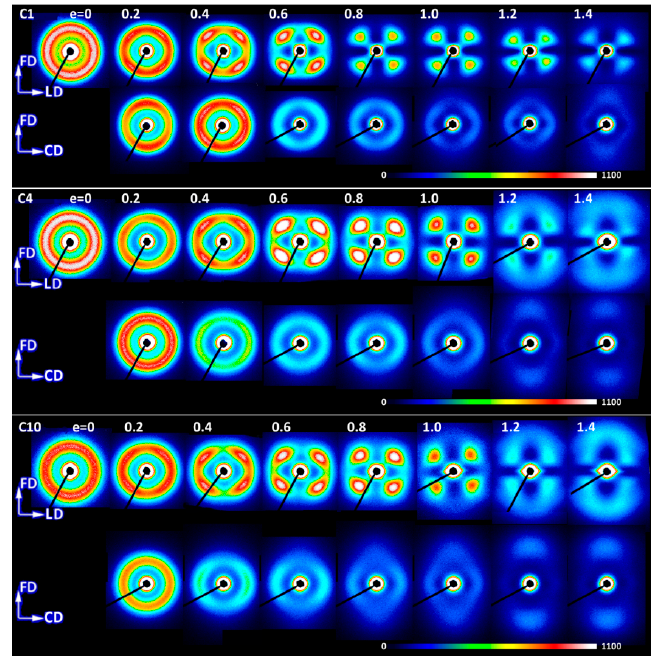
Figure 17. The 2-D SAXS patterns of samples of C1, C4 and C10 copolymers deformed to various strain (indicated) in the plane-strain compression. Patterns obtained in transmission with the primary beam along CD (first, third and fifth row) and along LD (second, fourth and sixth row). The flow direction (FD) is